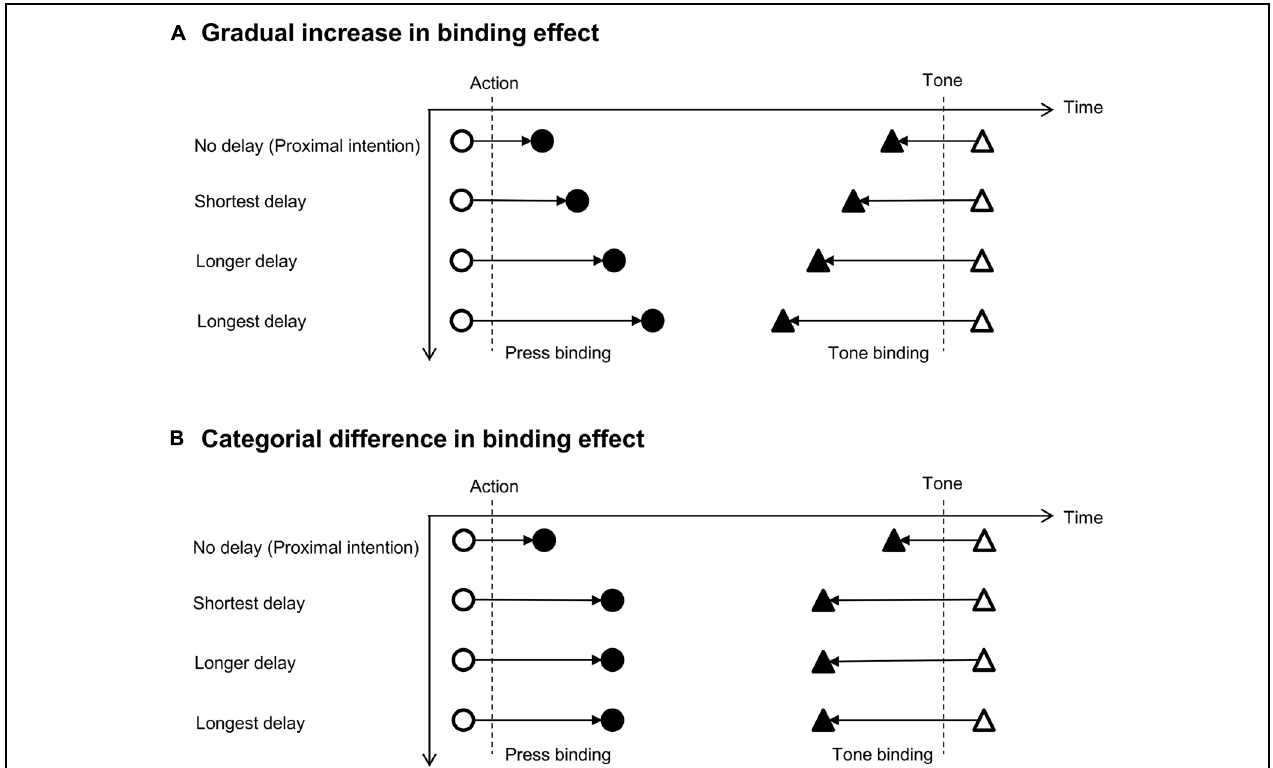
FIGURE 1 | Schematic illustration of the two hypotheses about the difference in binding effect across delays between intention and action. The binding effect is defined as a shift from baseline in the perceived time of action and tone. Press is marked by circles and tone is marked by triangles. Open symbols indicates baseline and solid symbols indicate operant conditions. (A) If a difference in binding effect between delayed and